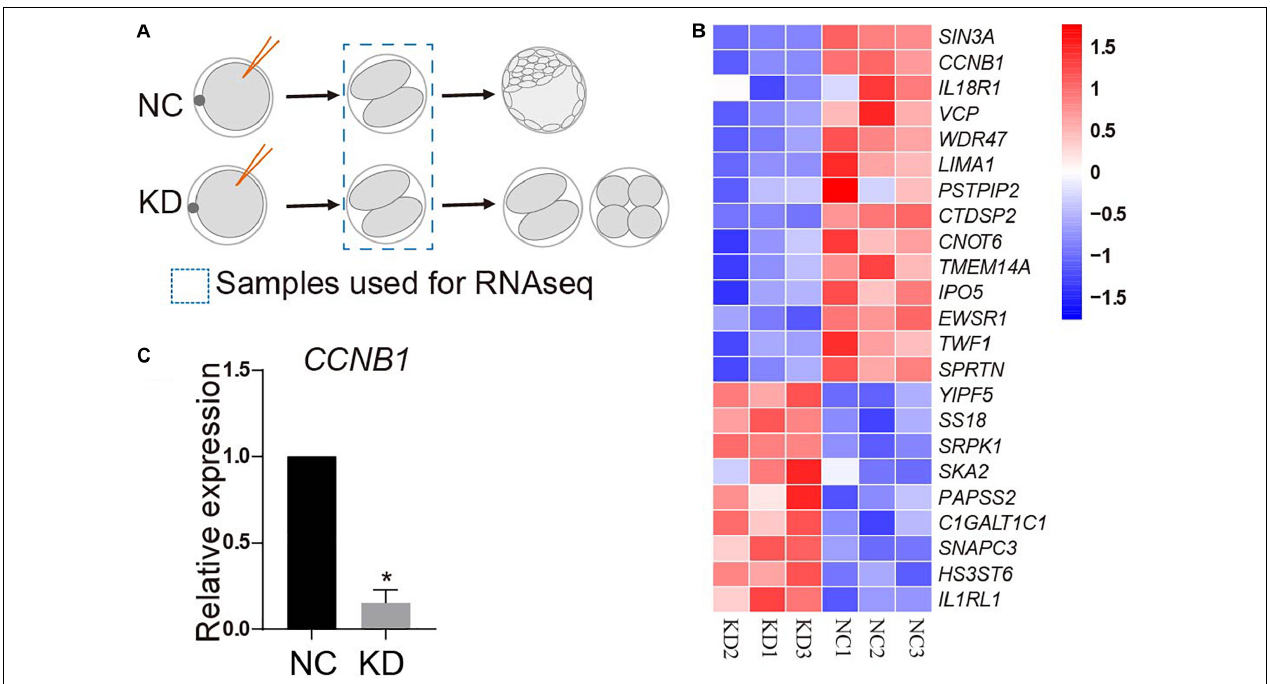
FIGURE 6 | RNA-seq analysis of porcine two-cell embryos deficient of SIN3A. (A) Schematic representation of the experimental design. MII oocytes were injected with NC or SIN3A siRNA followed by parthenogenetic activation. Two-cell embryos in each group after being cultured for 32 h were collected for RNA-seq. (B) Heatmap showing different expression genes (DEGs) between NC and KD embryos. Three independent replicates were performed. (C) Validation of the expression of CCNB1 mRNA in NC and KD two-cell embryos by qPCR. Three independent replicates; all data were represented as mean ± SEM, * P <